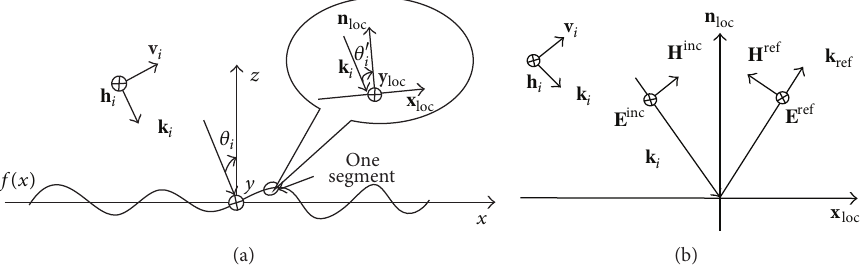
Figure 1: The illustration of the scattering problem from a sea surface, (a) the global coordinate system, and (b) the local coordinate